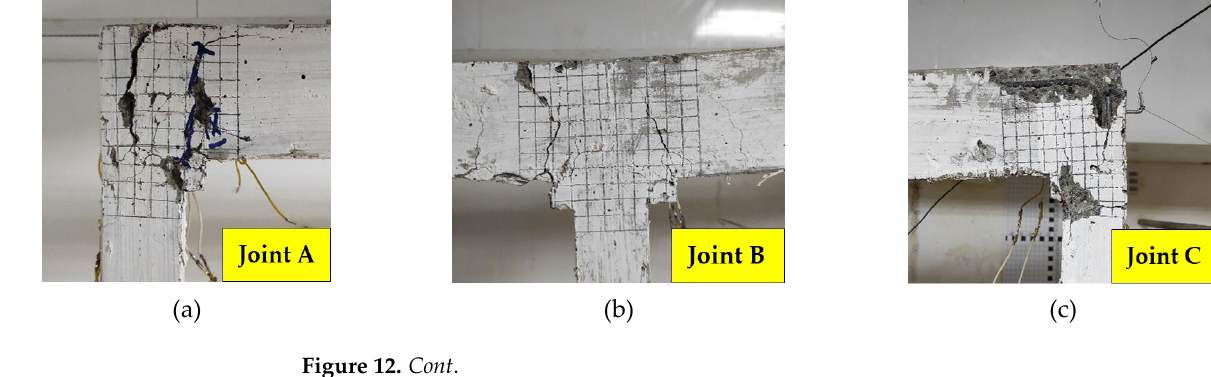
Figure 11. Video processing data for deformation and failure of the test frame under the corner column removal scenario.